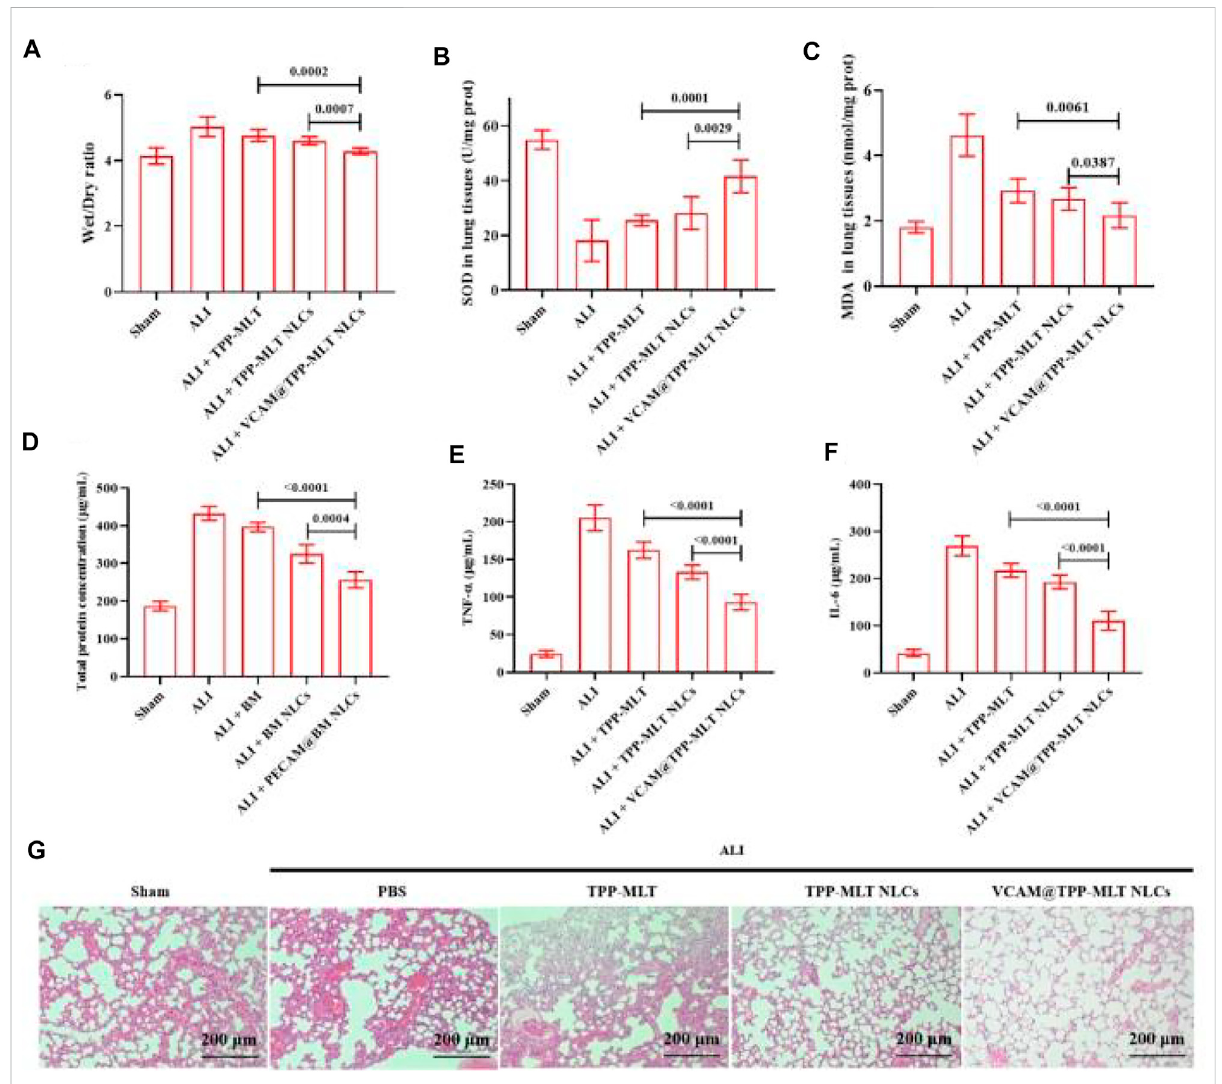
FIGURE 9 Invivo pharmacodynamicevaluationofVCAM@TPP-MLT NLCs. (A) Wet/dryratiooflungtissuesinALImiceafter treatedwithVCAM@TPP-MLT NLCs, TPP-MLT andTPP-MLT NLCsas control. (B) and (C) TheeffectsofVCAM@TPP-MLT NLCson thechangesofSODand MDAinthelungtissues of ALI mice. (D) The effects of VCAM@TPP-MLT NLCs on the changes of total protein concentration in BALF of ALI mice. (E) and (F) The effects